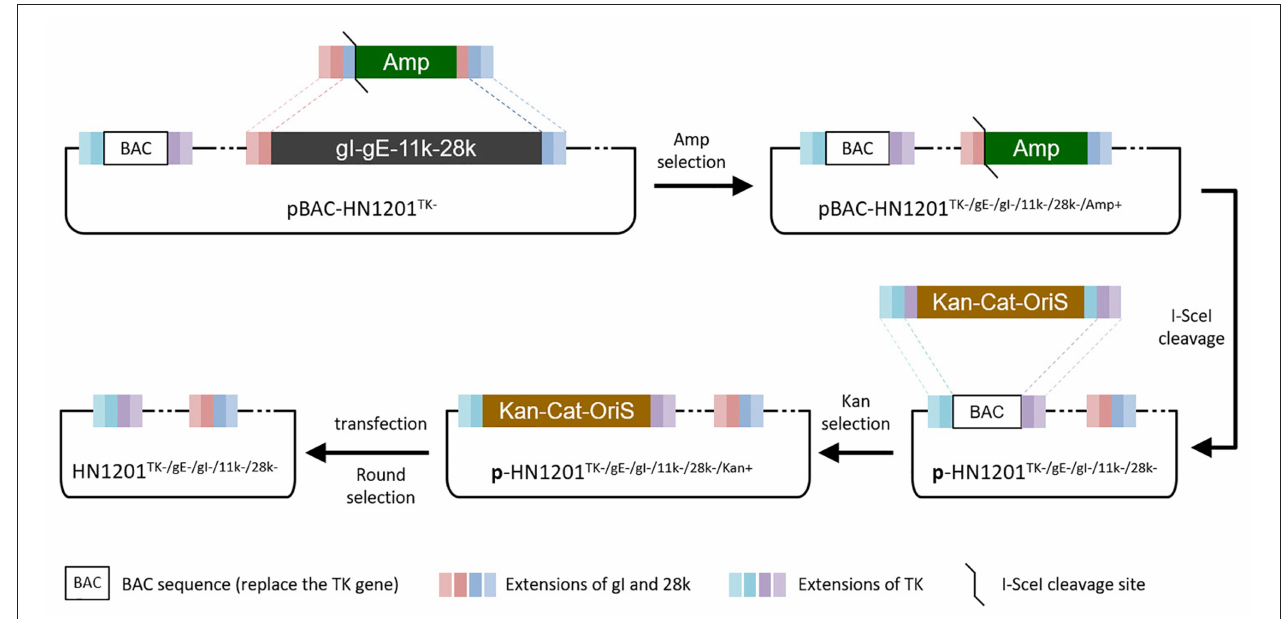
FIGURE 1 | Overview of strategies for the TK/gE/gI/11k/28k deletion. Boxes of the same color represent identical sequences.